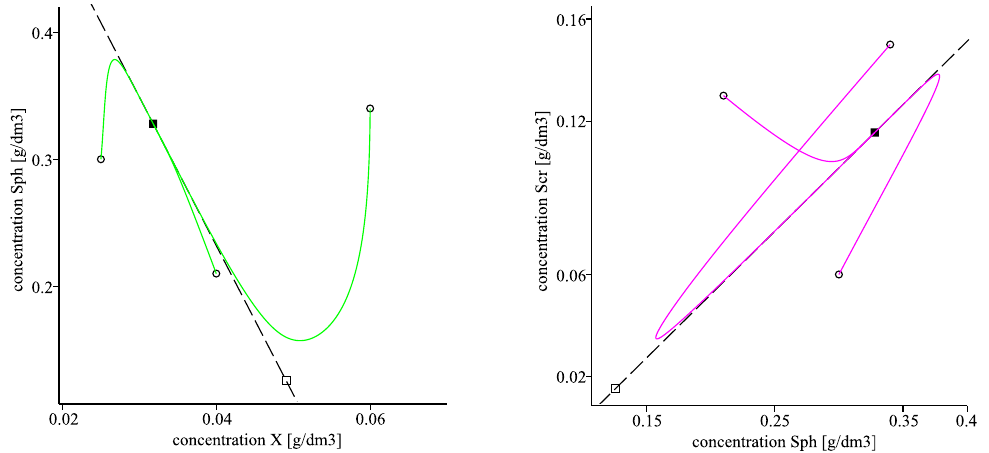
Figure 5. D = 0.08. Projections of the trajectories in the ( X , S ph ) -phase plane ( left ) and in the ( S ph , S cr ) -phase plane ( right ) with three different initial points, denoted by circles. The corresponding equilibrium components of E 3 are marked by solid boxes, of E 2 are denoted by boxes. The dash lines present projections of the invariant planes S ph + k ph X = S 0 S ph − KS cr = S 0 (right).